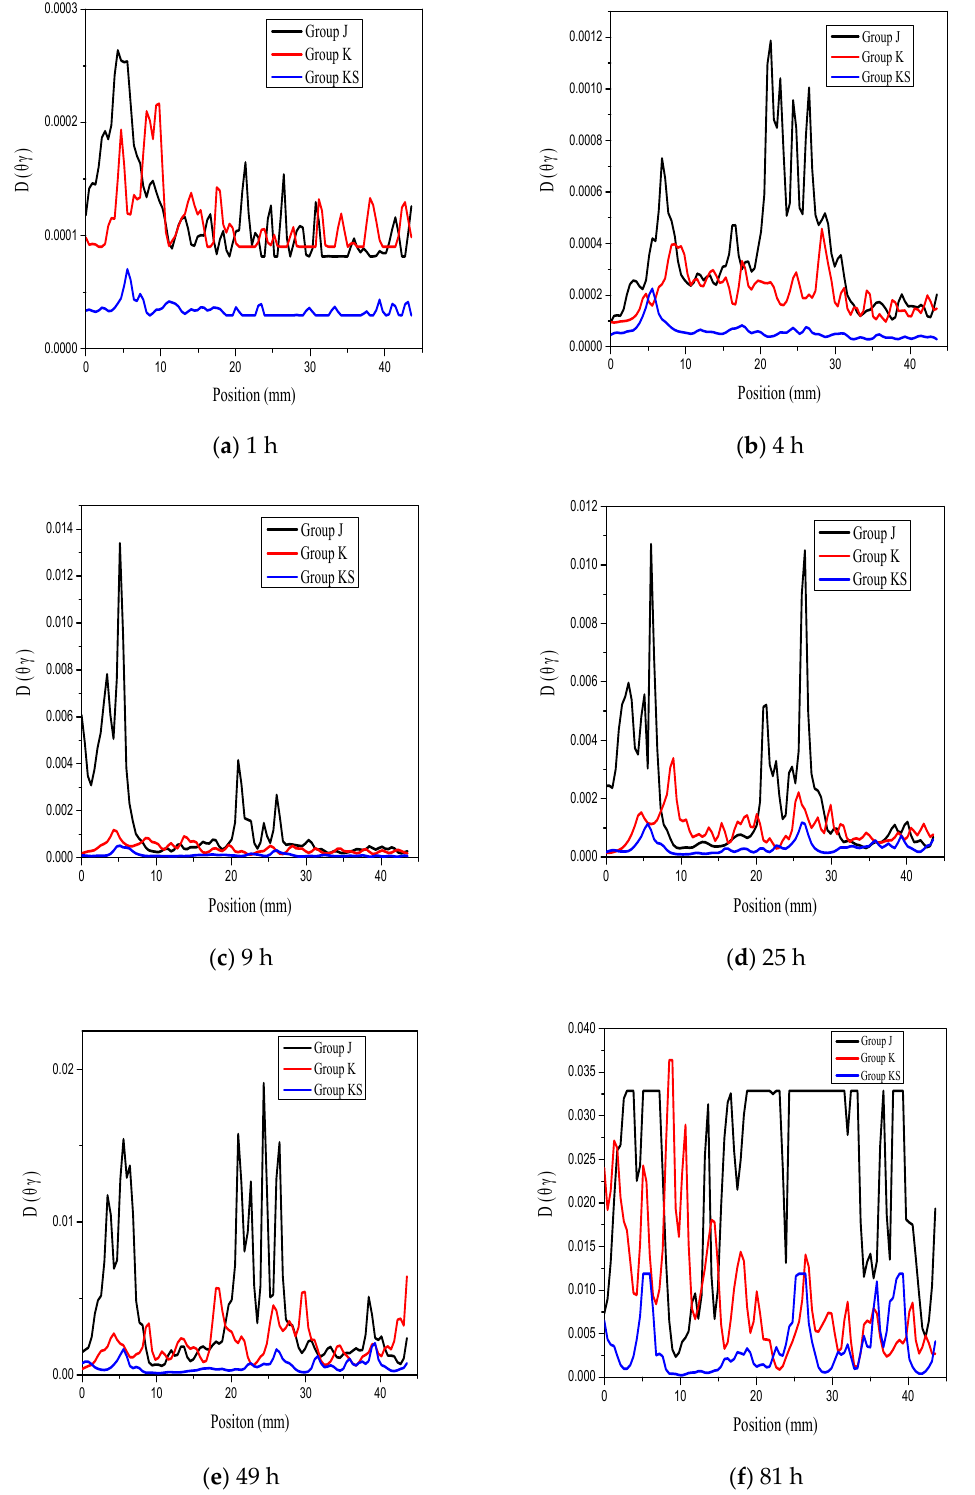
Figure 6. Comparison of the exponential 𝐷(𝜃𝛾) at different time intervals.